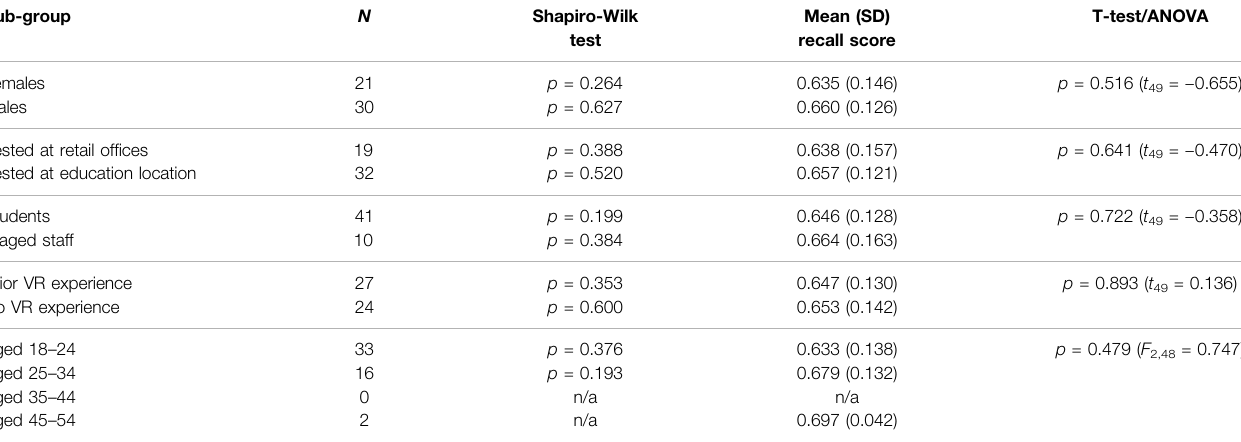
Prior VR experience